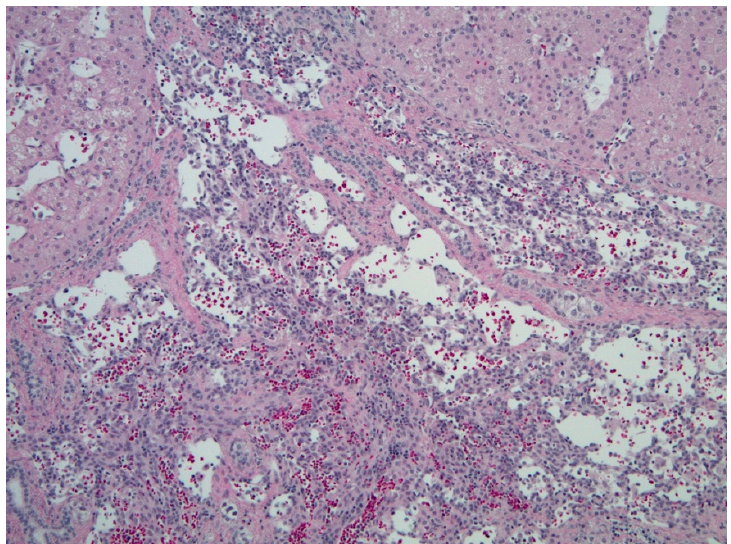
Figure 3. Hepatic hemangioma (hematoxylin & eosin (H&E), 10× magnification). Vascular channels lined by benign-appearing endothelial cells, with surrounding hepatic parenchyma.